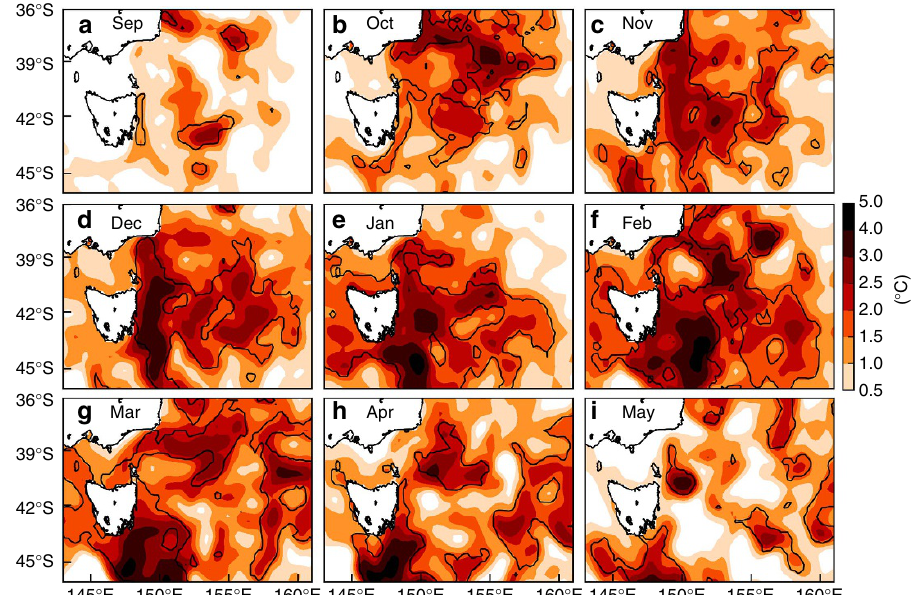
Figure 3 | Monthly mean SSTanomalies off southeastern Australia from September 2015 to May 2016. Sea surface temperature data is NOAA OI SST. Only positive anomalies are shown, monthly for ( a-i ) Sep 2015 through May 2016; anomalies are relative to the 1982–2005 base period. Black contours enclose areas where at least 90% of the days in that month were part of an identified MHW.